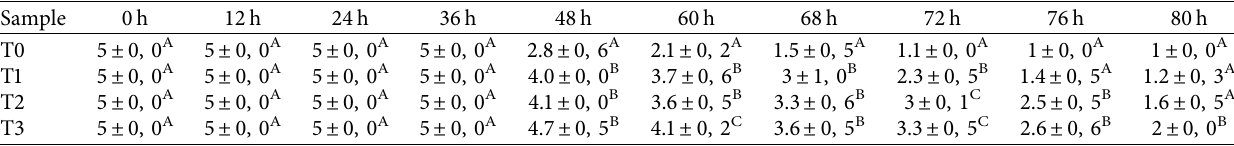
Table 3: The texture of meatballs coated with smoke powder of various pyrolysis temperatures.